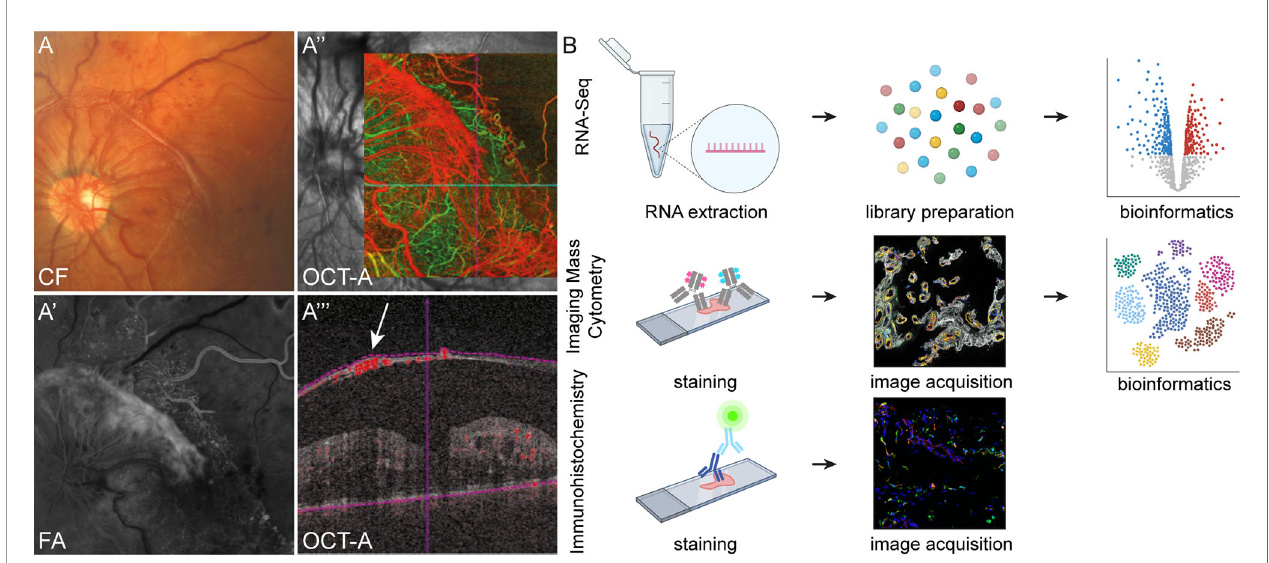
FIGURE 1 | Experimental setup. Retinal neovascularization membranes (RNV) were visualized prior to surgery via funduscopic examination (A) color fundus, CF), fl uorescein angiography, FA (A ’ ) and optical coherence tomography angiography, OCT-A (A ’’ and A ’’’ ). A ’’’ The arrow points to a preretinal membrane interspersed with blood vessels. (B) Work fl ow for tissue processing. RNV and control tissue samples (epiretinal membrane and internal limiting membrane, not shown) for RNA sequencing were stored in RNAlater immediately upon resection before RNA extraction and generation of fi rst-strand cDNA were performed (upper panel). Following library preparation and RNA sequencing, bioinformatic analyses were conducted. For Imaging Mass Cytometry (IMC), excised tissue samples were collected in formalin, processed for paraf fi n embedding (FFPE, middle panel) and sectioned. For staining of tissue sections, a compilation of 27 metal isotope-conjugated antibodies was applied before image acquisition. In the following, segmentation of IMC data via supervised machine learning was conducted prior to high- dimensional data analysis. Conventional immunohistochemistry (IHC, lower panel) was performed on cryo-conserved tissue sections and visualized by confocal